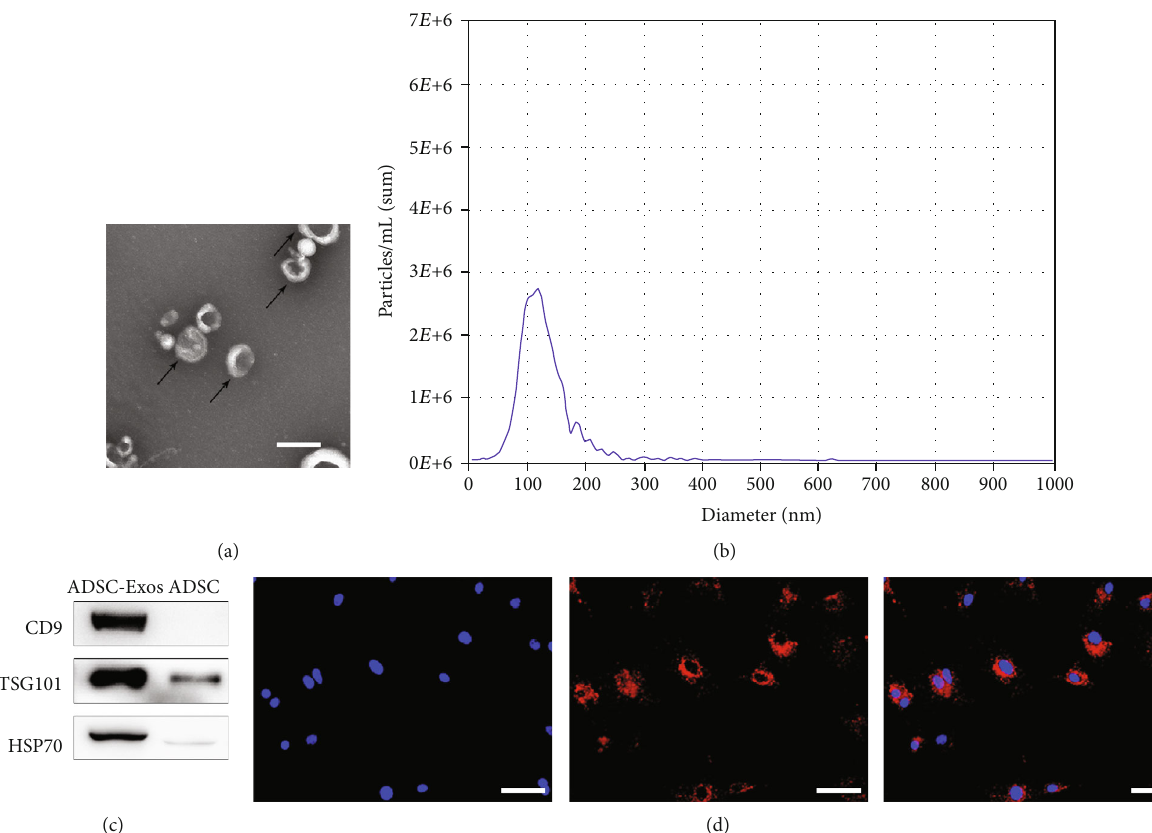
Figure 2: Characterization of ADSC-EVs. (a) Morphology was observed under a transmission electron microscope. (b) Particle size distribution. (c) Western blot was used to detect EVs surface markers. (d) fl uorescent microscopy analysis of PKH26-labeled ADSC-EVs internalization RPMCs. Nuclei were counterstained with DAPI. Bars,